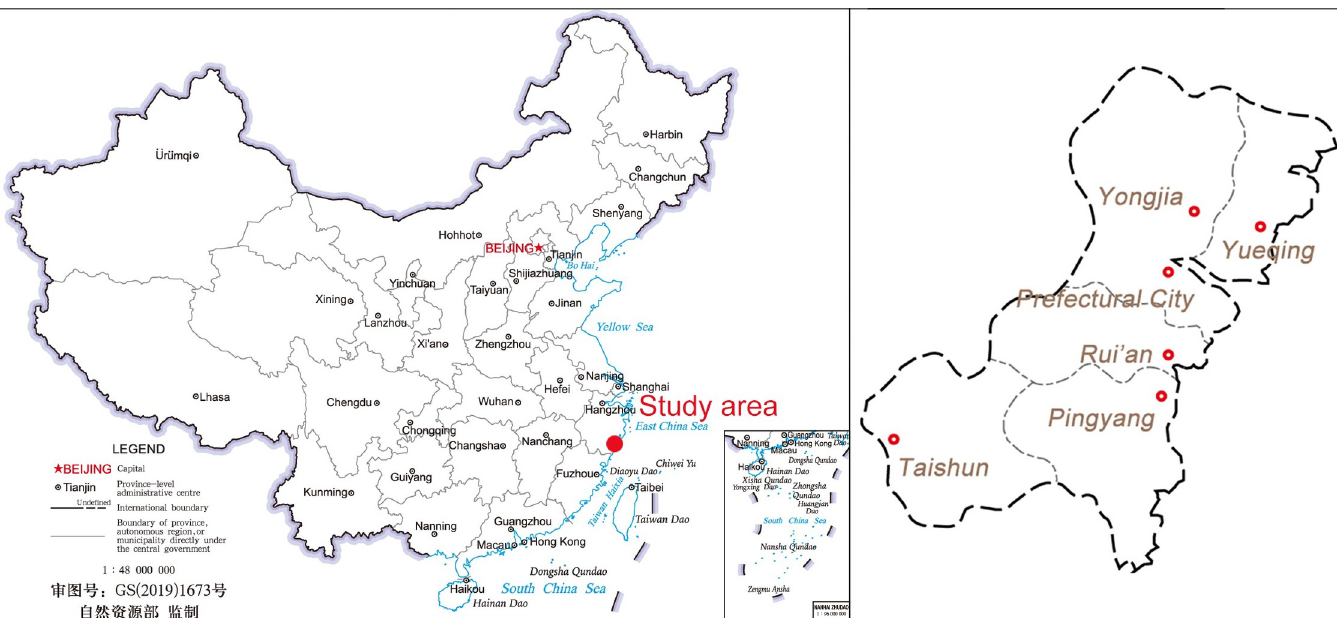
Fig 1. Location and administrative divisions of the study area. The map of China (left) was provided by Ministry of Natural Resources of China (Approval number: GS